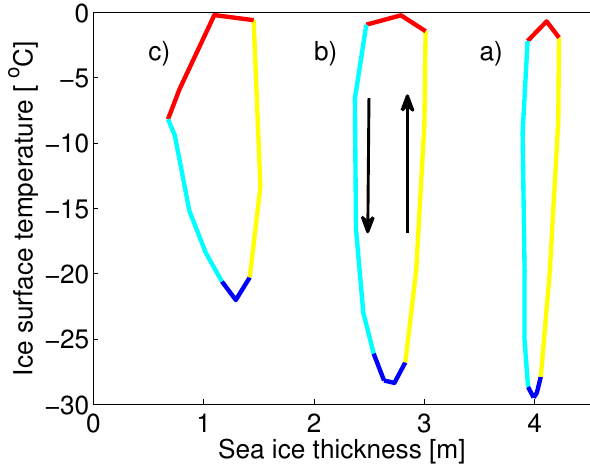
Fig. 1. Seasonal variation of sea-ice thickness and ice surface tem- perature in the region north of 80 ◦ N for the CCSM3 model. The blue line represents the growing season, yellow is warming, red is melting and cyan is the cooling season. The three curves are (a) PMIP2 PI, (b) PMIP2 MH, and (c) CMIP3 2 × CO 2 climate. The seasonal progression of the sea ice is anti-clockwise in the thickness–temperature diagram. In the warmer climates the sea- sonal variation in sea-ice thickness increases and the variation in sea-ice surface temperature